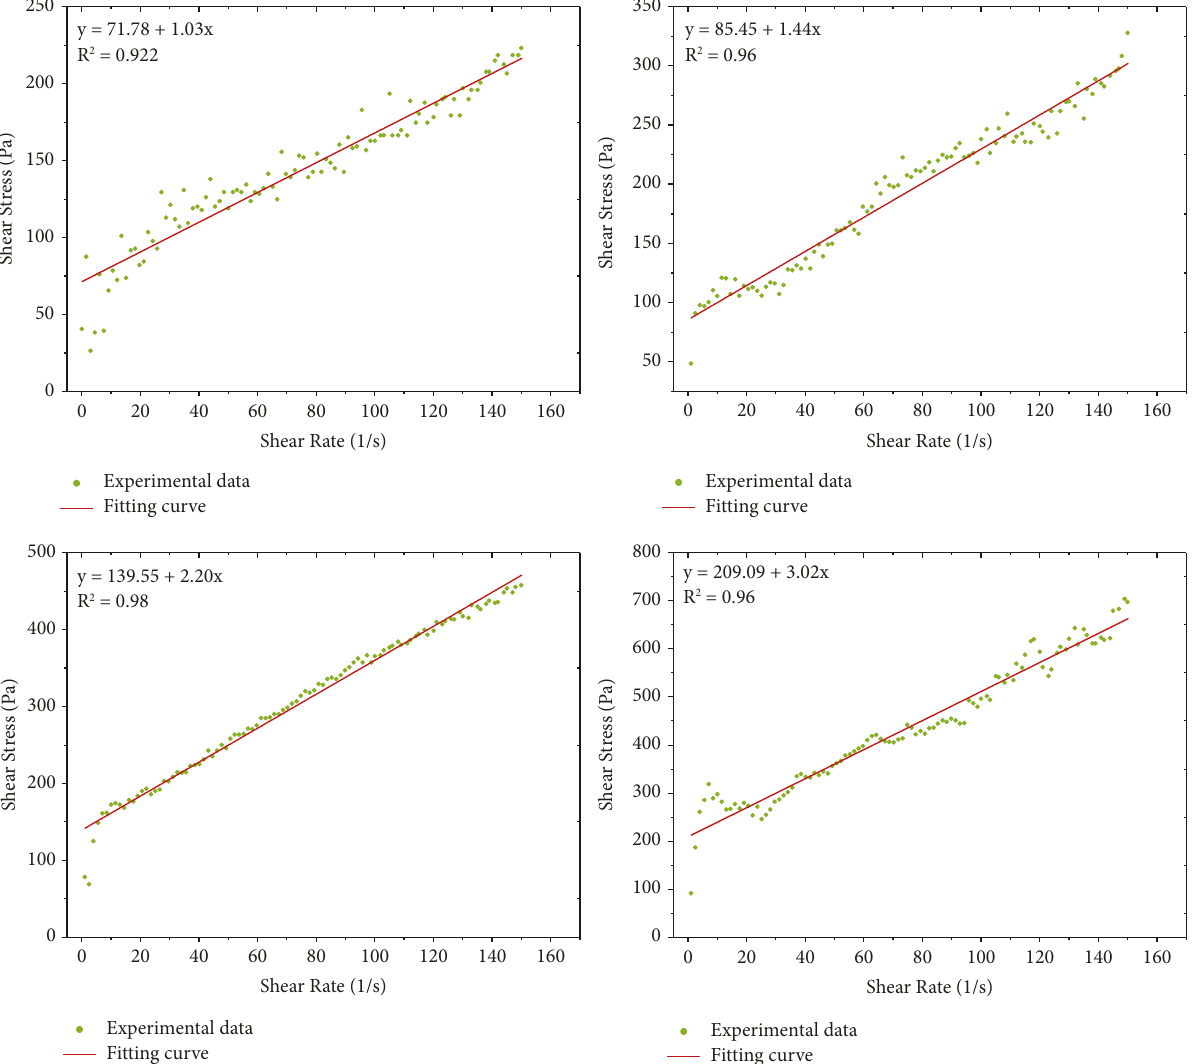
Figure 5: Rheological test